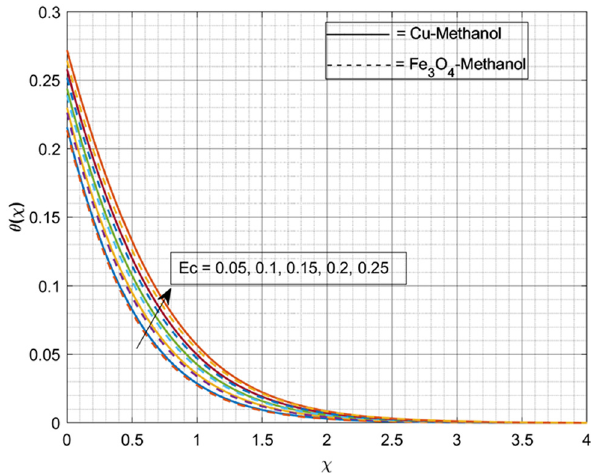
Figure 7: Sway of Ec on θ .